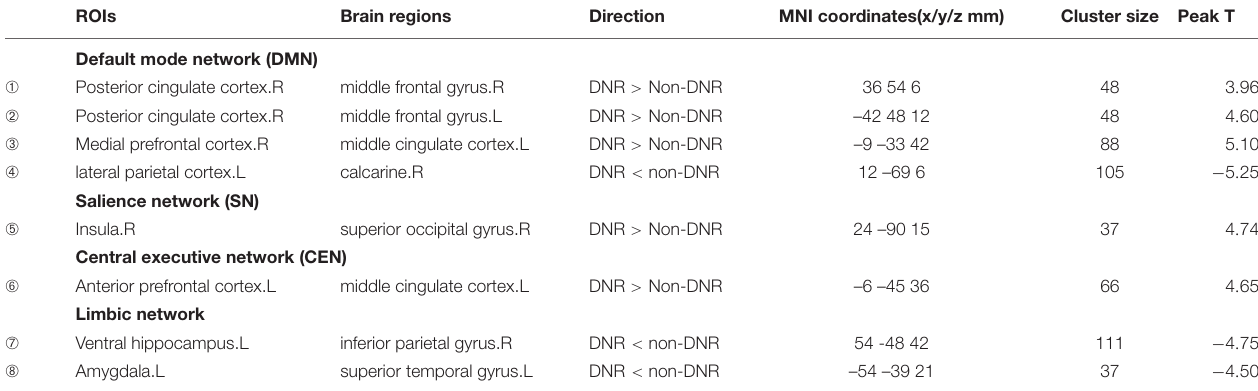
TABLE 2 | Brain regions showing seed-based FC differences before surgery between the DNR and non-DNR groups. ROIs Brain regions Direction MNI coordinates(x/y/z mm) Cluster size Peak T